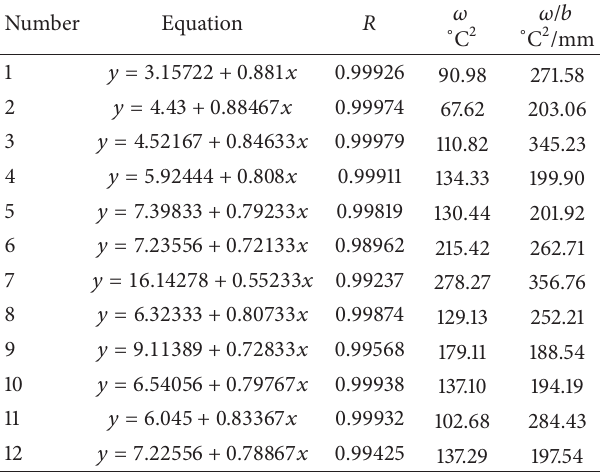
Table 2: Fitted curve equations, linear correlation coefficients, temperature factors, and temperature factors per unit